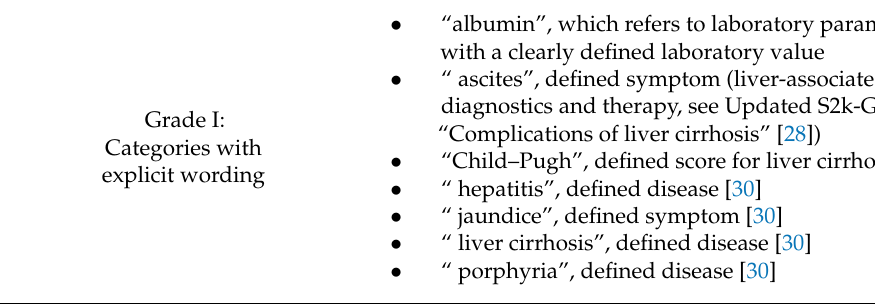
Table 2. Categories evaluated for explicitness of